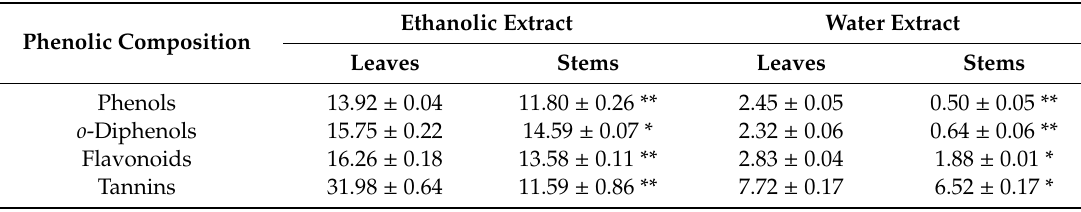
Mean composition of sampled P. oleracea from three replications ± standard deviation. Di ff erent symbols (*, **), for the same parameter, within columns indicate significant di ff erences (* p < 0.05; ** p < 0.01) between the two aerial parts of the plant within the same extraction